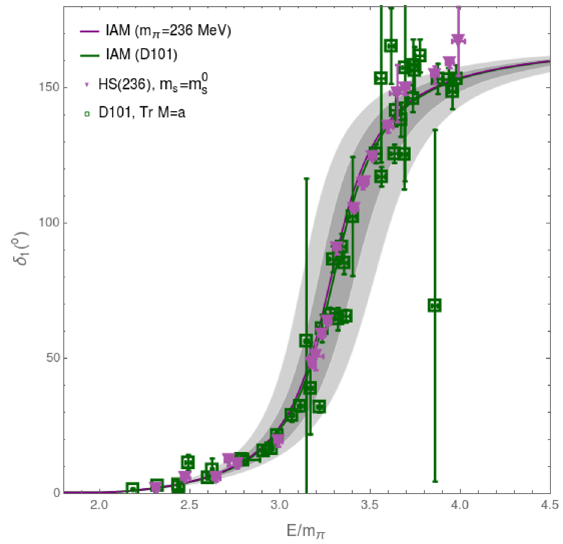
Figure 21 . Phase shift lattice data corresponding to the D101 ensemble in comparison with the HadSpec data for m (cid:25) = 236 MeV and the IAM solution for